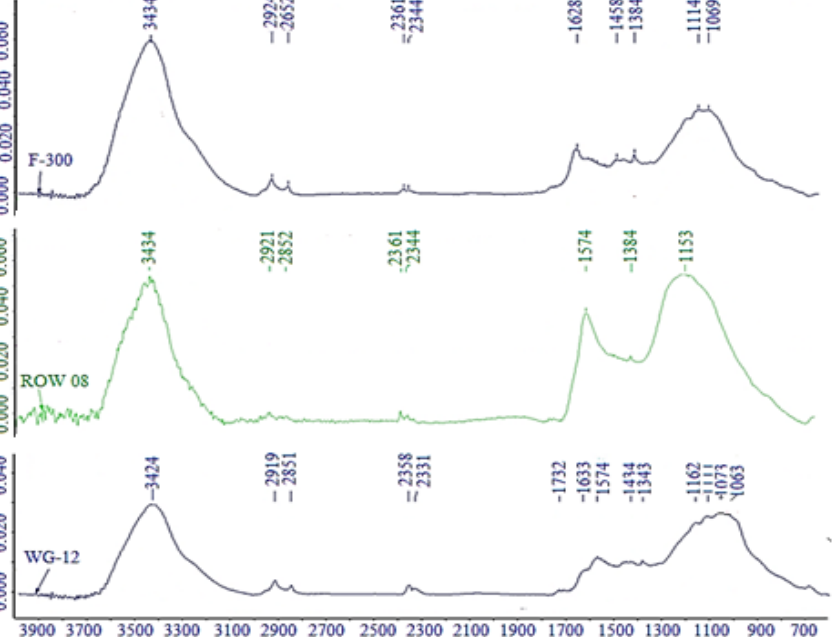
Figure 8. FTIR spectra for activated carbons WG-12, F-300 and ROW 08 Supra.